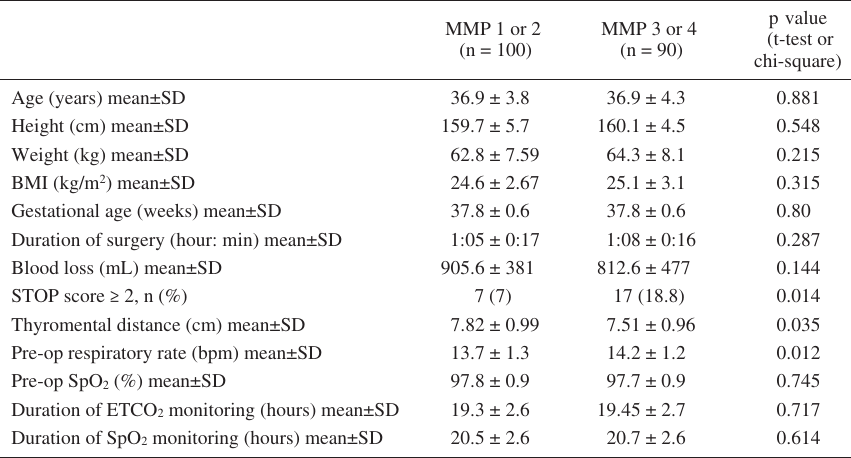
Table 1. Patient